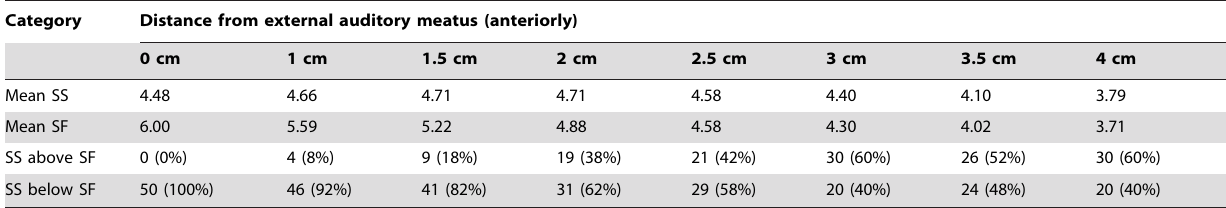
Table 1. Mean value of length of Squamous suture and Sylvian fissure in 50 patients (Right).